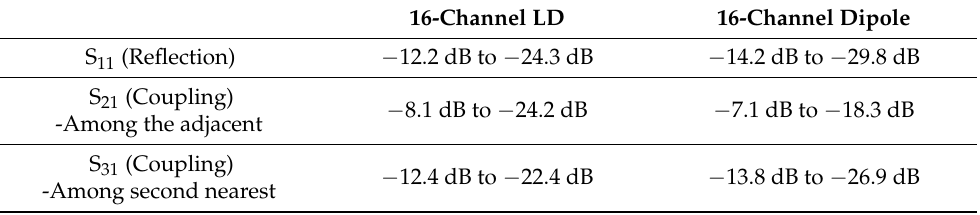
Table 1. Measured S ‐ parameters of the 16 ‐ channel LD and dipole antenna arrays. S 11 is the reflection coefficient of each channel, and the S 21 and S 31 are the coupling coefficients between adjacent elements and elements separated by an element between them (second nearest), respectively.